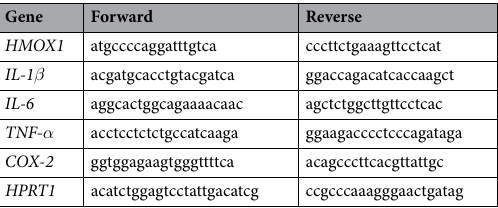
Table 4. List of human genes used for gene expression analyses. HPRT1 was used as the housekeeping